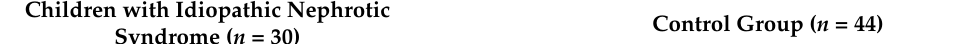
Table 1. Characteristics of the groups (population described in the previous research) and their selected anthropometric and laboratory parameters [22].